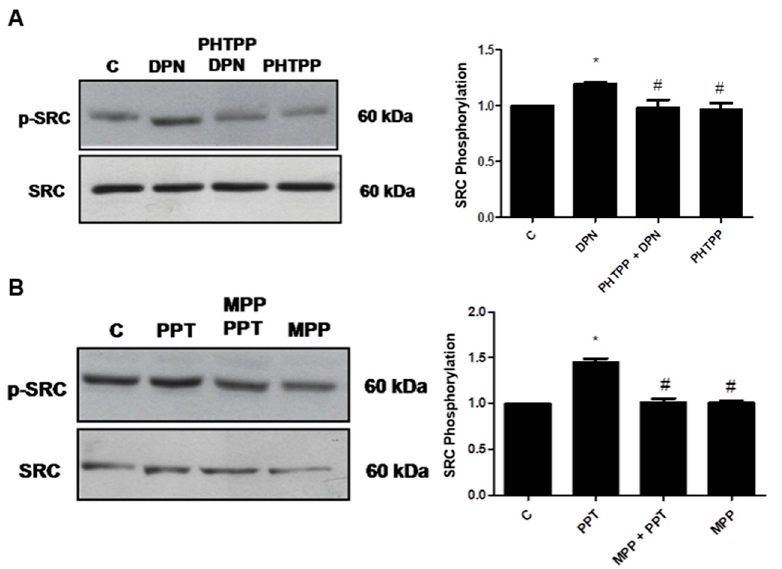
Figure 3. Effects of ER β - (PHTTP) or ER α -selective antagonists (MPP) on SRC (Tyr419) expression and phosphorylation in androgen-independent prostate cancer cells PC-3 induced by DPN or PPT. The cells were incubated in the absence (C, control) and presence of DPN (10 nM) for 30 min ( A ) or PPT (10 nM) for 1 h ( B ) at 37 ◦ C. The cells were also pre-treated with PHTPP (10 nM) ( A ) or MPP (10 nM) ( B ) for 30 min, and then incubated or not, respectively, with DPN for 30 min ( A ) or PPT for 1 h ( B ). Phosphorylated SRC (p-SRC) and total SRC were detected by Western Blot. The immunoassay was performed with anti-phosphorylated SRC (upper panel) and anti-total SRC antibodies (lower panel). The relative position of SRC was determined from the molecular weight standard. The data shown are representative of three independent experiments. Densitometric analysis was performed of the results obtained from each band, normalized by the expression of the total SRC and expressed in relation to the control (C = 1). Results were plotted (mean ± SEM) of three independent experiments. * Significantly different from control (C) ( p < 0.05, ANOVA and Newman-Keuls). # Significantly different from DPN for 30 min or PPT for 1 h ( p < 0.05, ANOVA and Newman-Keuls).